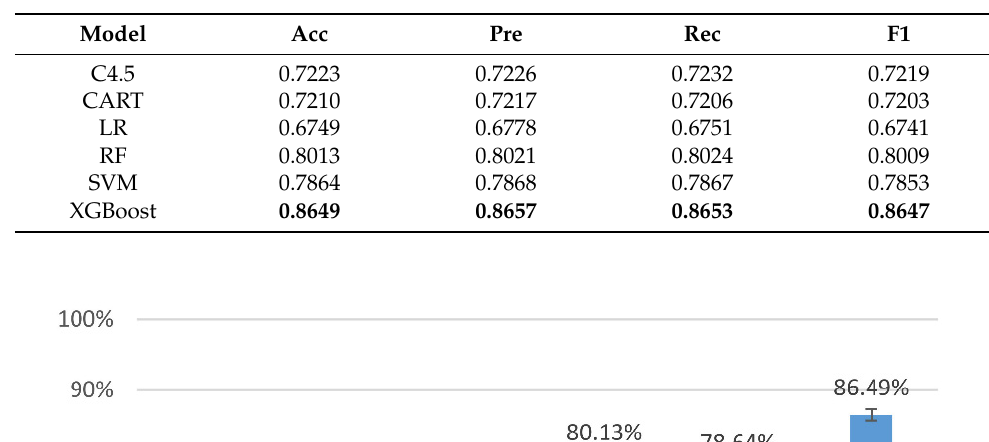
Table 2. Generalizing model for the three-level stress classification.